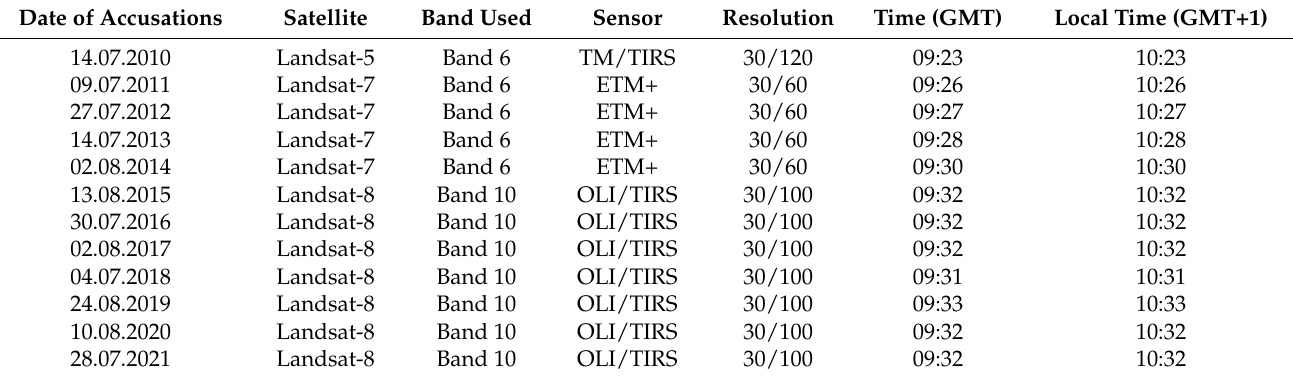
Table 1. Acquisition dates and some parameters of the Landsat images used for this